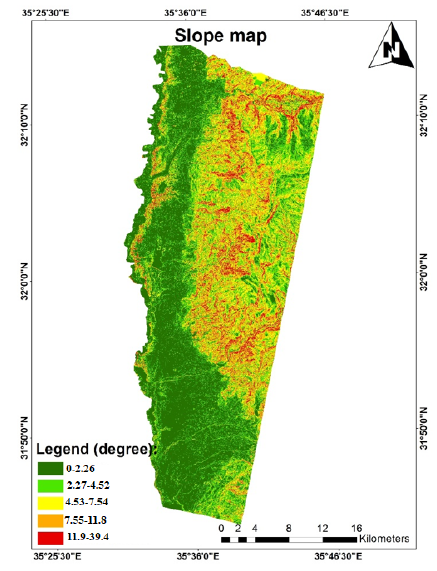
Fig. 3. Land cover classes map of the study area Fig. 4. Slope map of the study